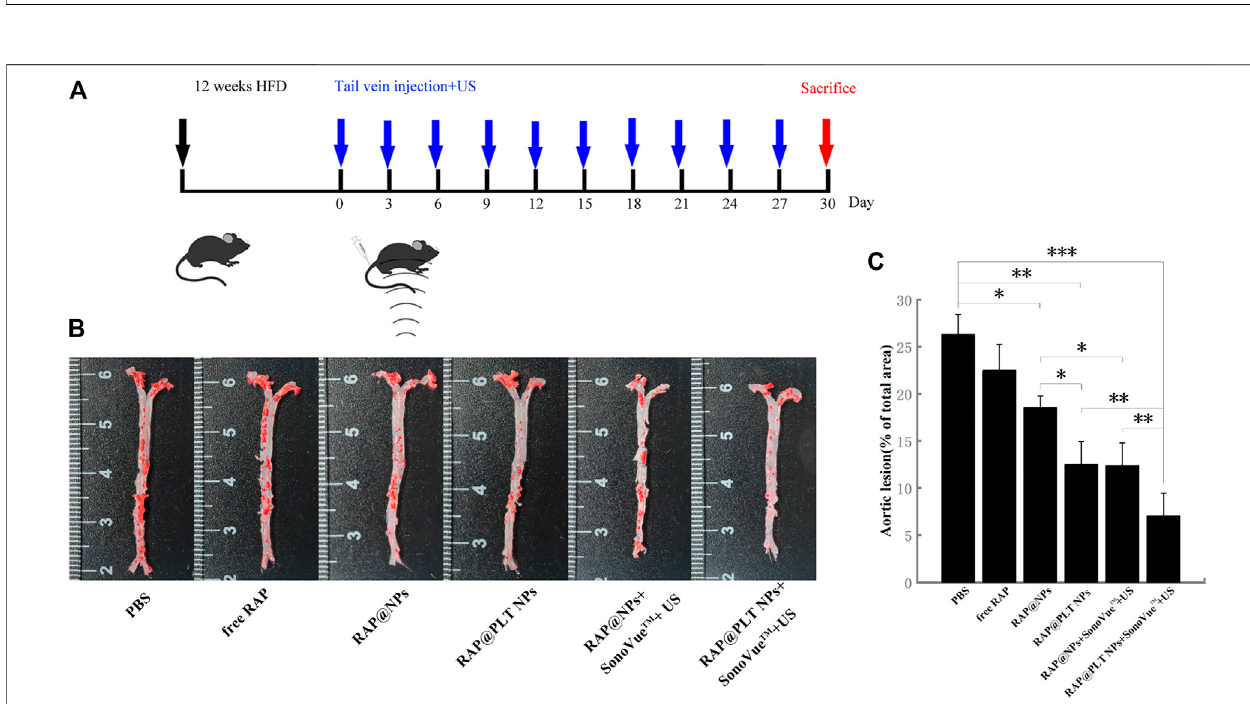
FIGURE5| AtherosclerosistreatmentinApoE − / − mice. (A) Theillustrationofvarioustreatmentin30 days. (B) TheenfaceORO-stainedimagesofaortasfromeach group. (C) Quantitative data of the atherosclerotic plaque